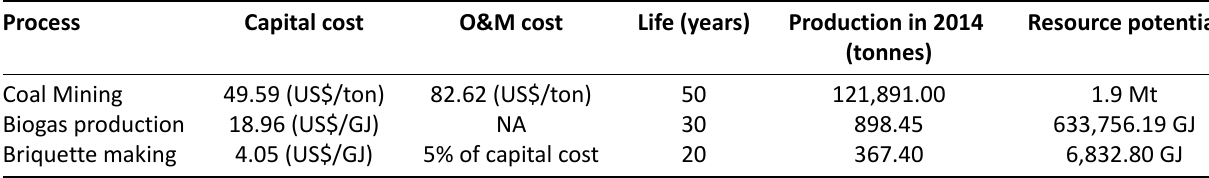
Table A10. Transformation processes other than power generation, data imputed based on DoI (2015), Department of renewable Energy (2015a) and DRE & UNDP (2014).